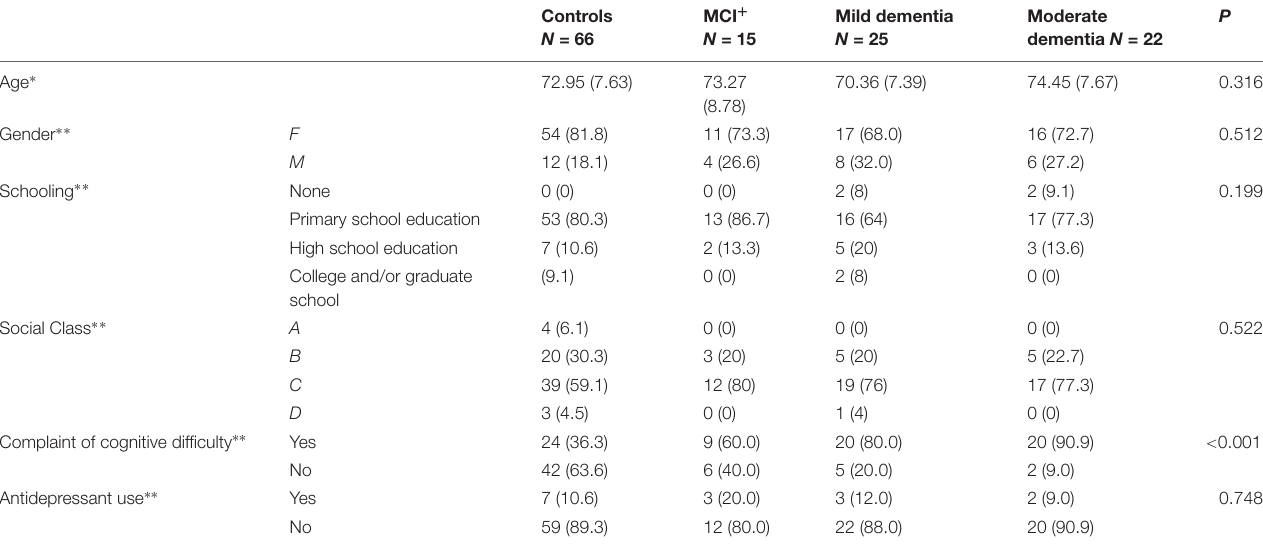
TABLE 1 | Comparison of demographic data and complaints of cognitive difficulties between the group of healthy individuals (controls) and the group of people mild cognitive impairment (MCI) and mild/moderate dementia (cases).